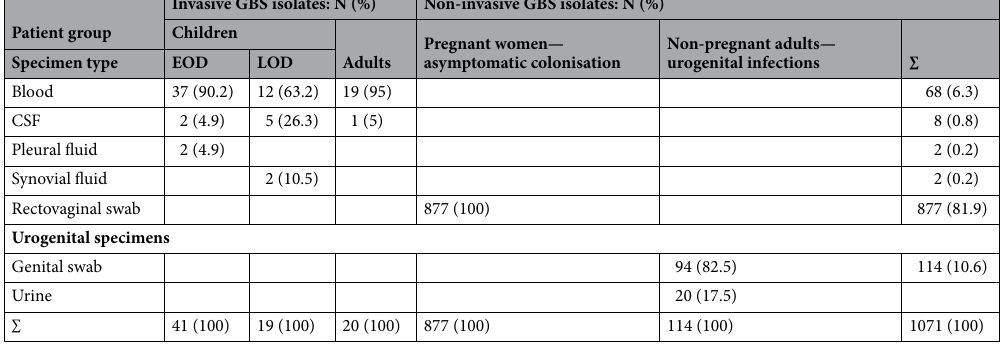
Table 1. Specimen distribution of 1071 invasive and non-invasive isolates of Group B streptococci within patient groups. CSF cerebrospinal fluid, EOD early-onset disease, LOD , late-onset disease, GBS Group B